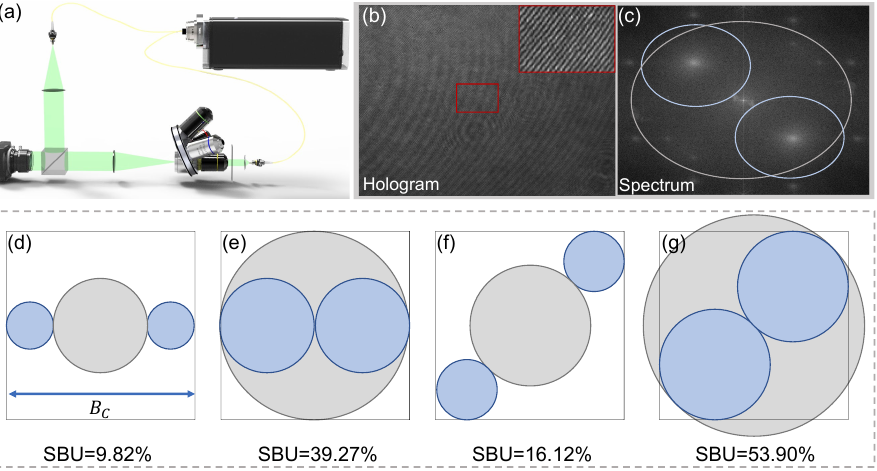
Figure 1. ( a ) Slightly off-axis interference optical path. ( b ) The captured low-carrier-frequency fringe under the slightly off-axis system. ( c ) The spectrum of the hologram. ( d – g ) The space bandwidth utilization (SBU) calculation results under the four different spectrum